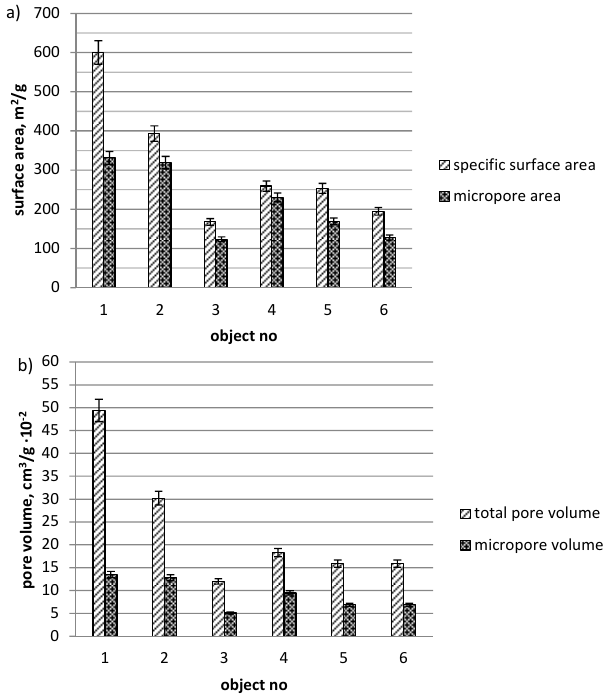
Figure 4. ( a ) Pore surface area and ( b ) volume of chars produced under atmospheric pressure.